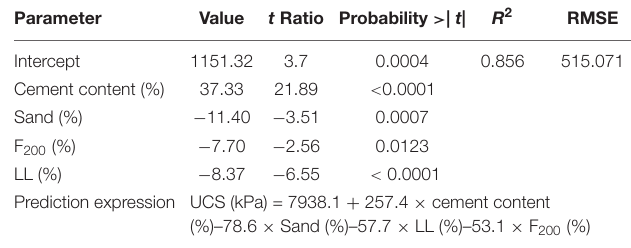
TABLE 4 | Multi-variate analysis results to predict GI after cement stabilization.